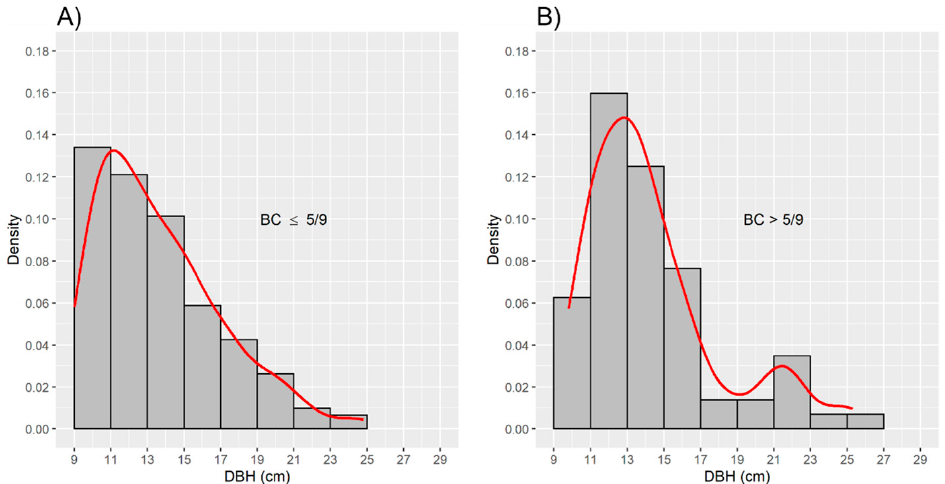
Figure 2. Example of Stem Diameter Distribution (SDD) differentiated according to the Bimodality Coefficient (BC) as ( A ) unimodal and ( B ) bimodal, and respectively fitted with a Weibull distribution and a Finite Mixture Model (red lines). Table 1. Description of metrics and associated groupings used as predictor variables: ALS